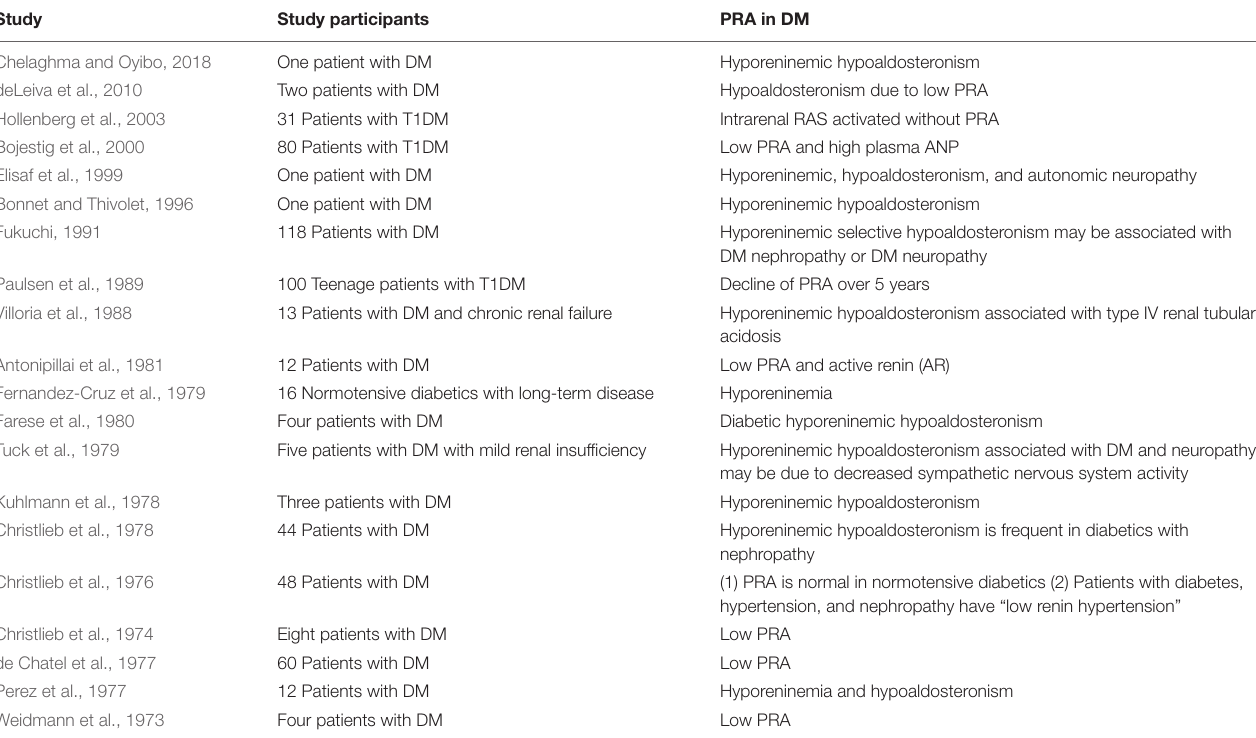
TABLE 3B | Clinical studies on low PRA in DN.